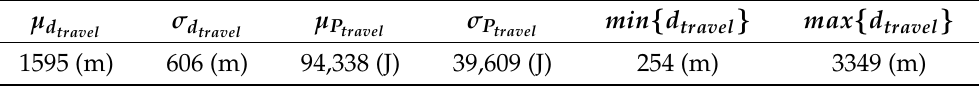
Table 5. Mean µ and standard deviation σ of the minimum-cost airspace volumization